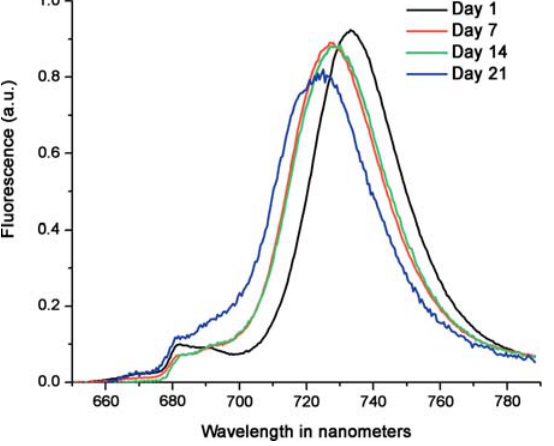
Figure 4. Extended Time of PS-I Stability on Dried Surface Fluorescence spectrum of a PS-I film containing 0.5% A 6 K was monitored for 3 wk. Negligible increase in fluorescence was observed at approximately 683 nm. A blueshift from approximately 735 nm to approximately 727 nm fluorescence was observed. Thus, it suggests that the PS-I complex retained most of its structural integrity under conditions examined. Such shifts have been noted under other conditions. DOI: